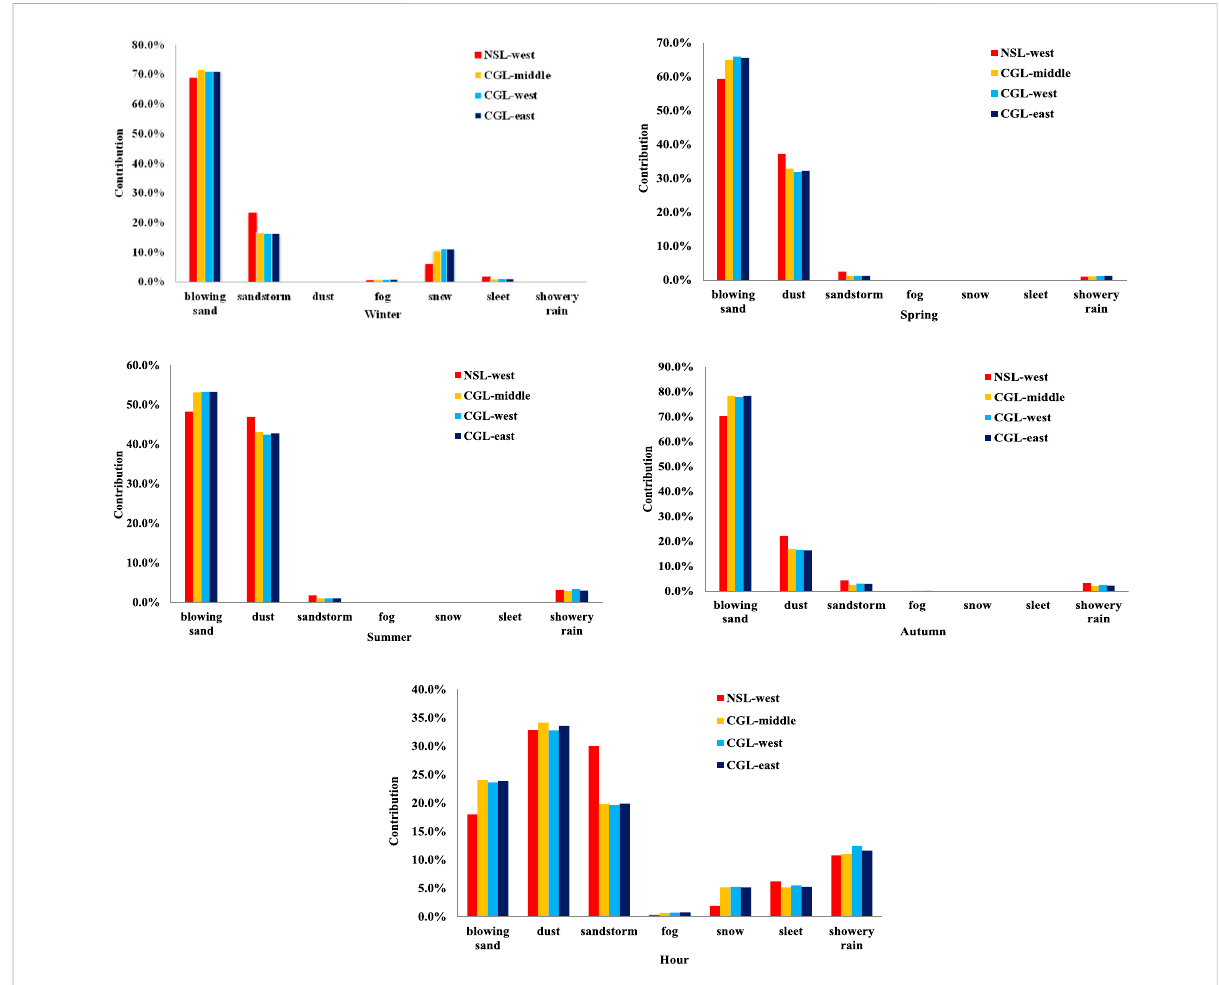
FIGURE 6 Seasonal and hourly contribution rates of different weather conditions to